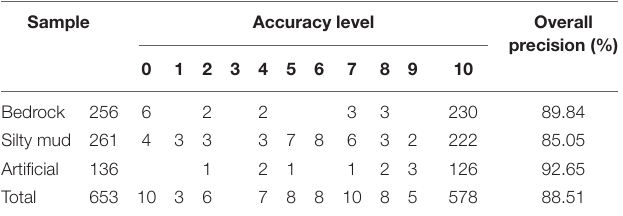
TABLE 3 | Precision of the 2015 interpreted intertidal wetland validated by field